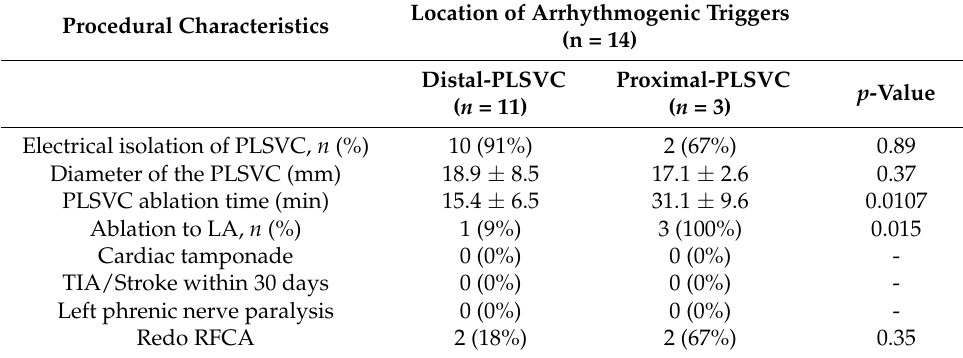
Table 3. Procedural Characteristics for Electrical isolation of PLSVC.